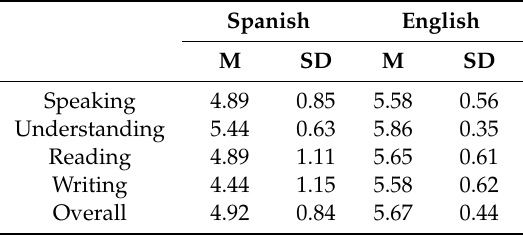
Table 2. Spanish and English self-rated